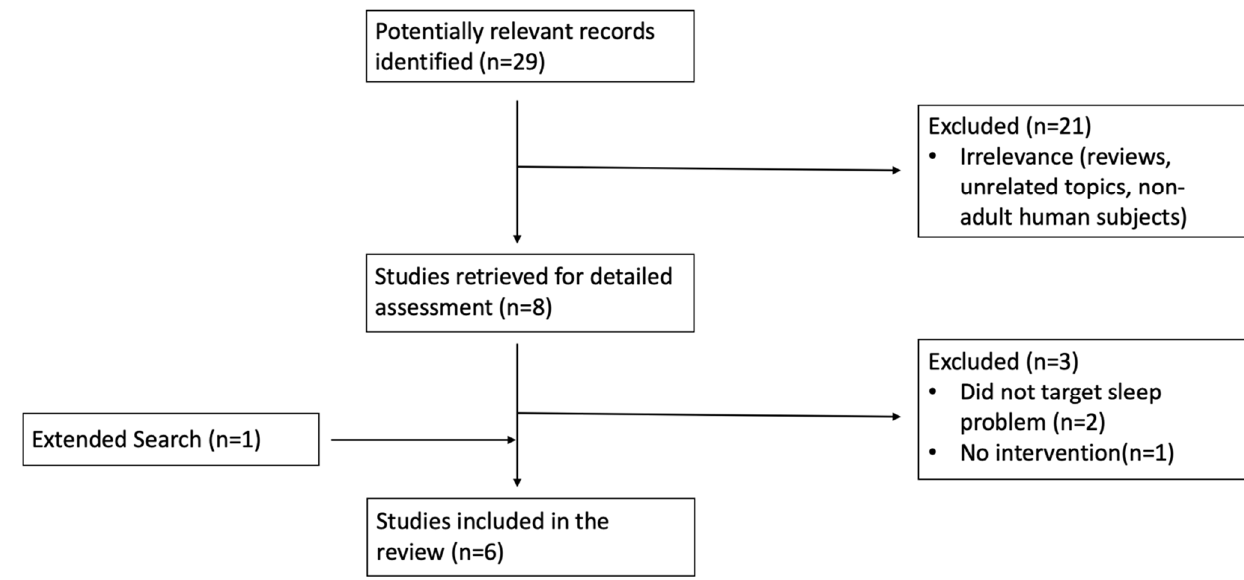
Figure 1. Flowchart of Literature Search using PubMed .